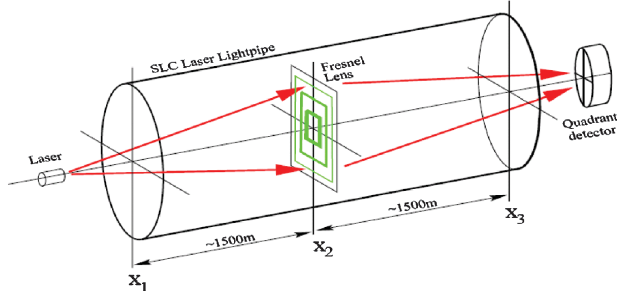
FIG. 22. (Color) Schematic of SLAC linear accelerator laser measurement system.